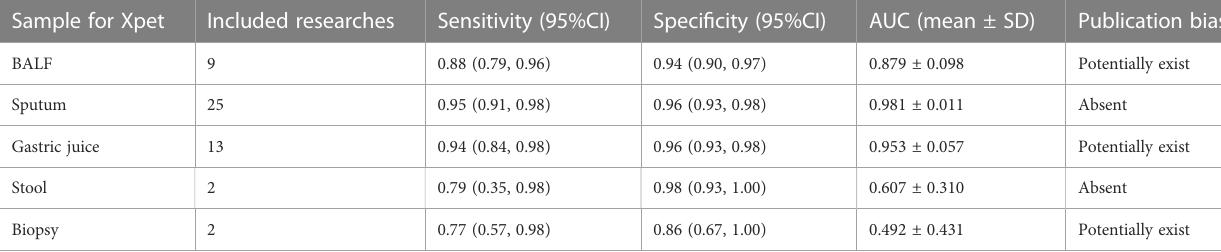
TABLE 1 Summary of pooled results on pulmonary TB